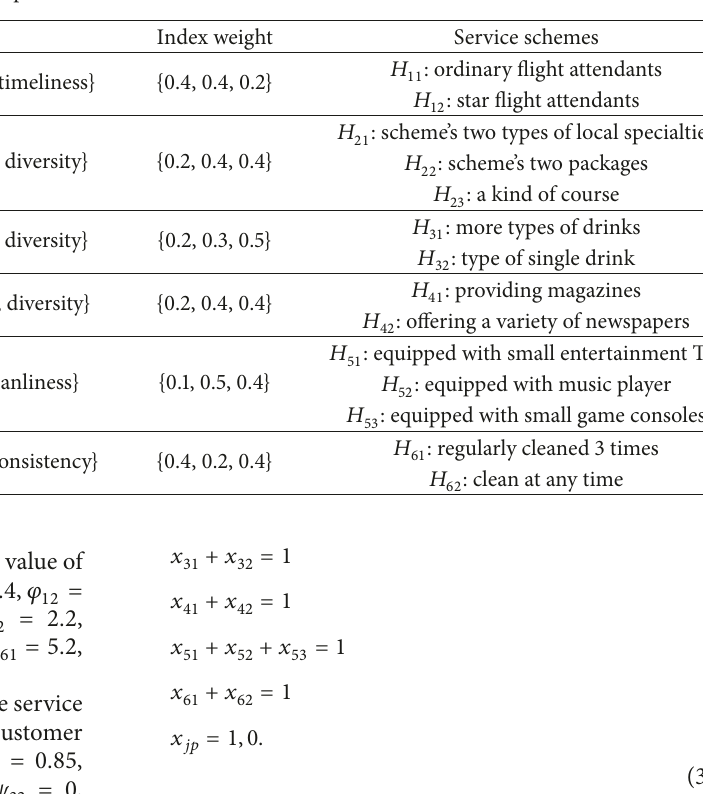
Table 7: Description of cabin services and